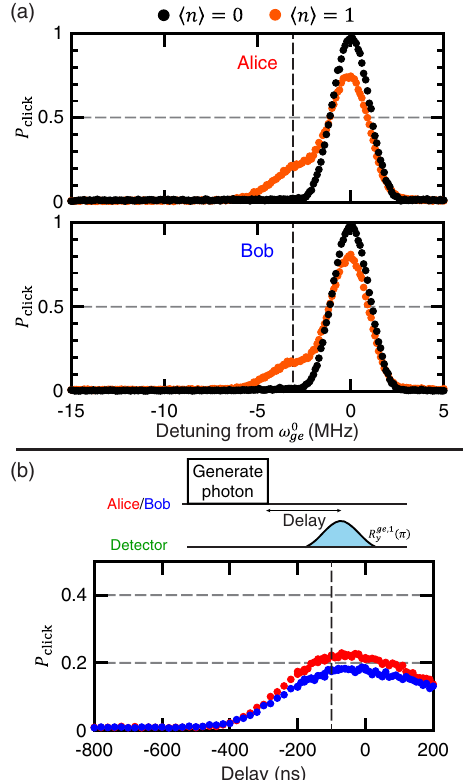
FIG. 10. Detector characterization. (a) Detector click proba- bility P as a function of the detuning of the detection pulse click for different input states from the Alice (top panel) and from ω 0 ge Bob (bottom panel) modules. The black dashed line indicates the frequency of the selective π -pulse for optimum discrimination of state j 1 i from state j 0 i . (b) Detector click probability P function of the delay between the end of the photon-generation pulse and the start of the selective detection π -pulse. In the remote entanglement experiment of Figs. 3 and 4, the pulses overlapped by 100 ns (black dashed